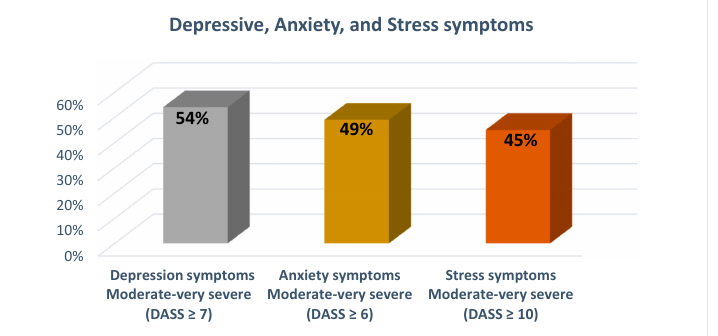
Figure 1. Depressive symptoms, anxiety, and stress among Arab students during COVID-19 (n = 420). Table 2 shows how depressive symptoms, anxiety, and stress are associated with de- mographic, health, and academic variables. Overall, participants reported moderate to very severe symptoms of depression, anxiety, and stress (i.e., 54%, 49.3%, and 45.2%, re- spectively). Women reported significantly higher symptom levels of depression and stress compared to men. Income, negative impact of COVID-19, academic difficulties, academic support, quality of online learning, and COVID-19 health concerns were found to predict depressive symptoms, anxiety, and stress. Region and job loss during the pandemic were significantly associated with symptoms of depression and anxiety, but not stress. Students from the south reported significantly higher symptoms of depression and anxiety com- pared to those from the center or the north of Israel. Table 2. Bivariate associations of demographic, health, and academic factors with mental health among higher-education students during COVID-19 pandemic (n = 420 ).